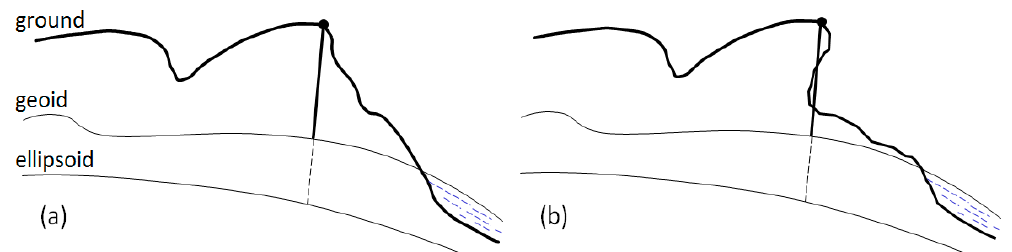
Figure 3. 2.5D representation of the Earth’s surface: general case ( a ) and exception ( b ).